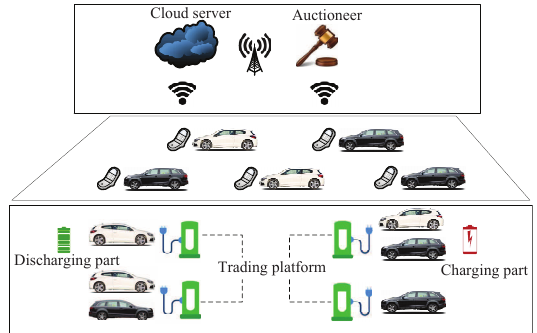
Figure 17. The architecture of the secure incentive mechanism.